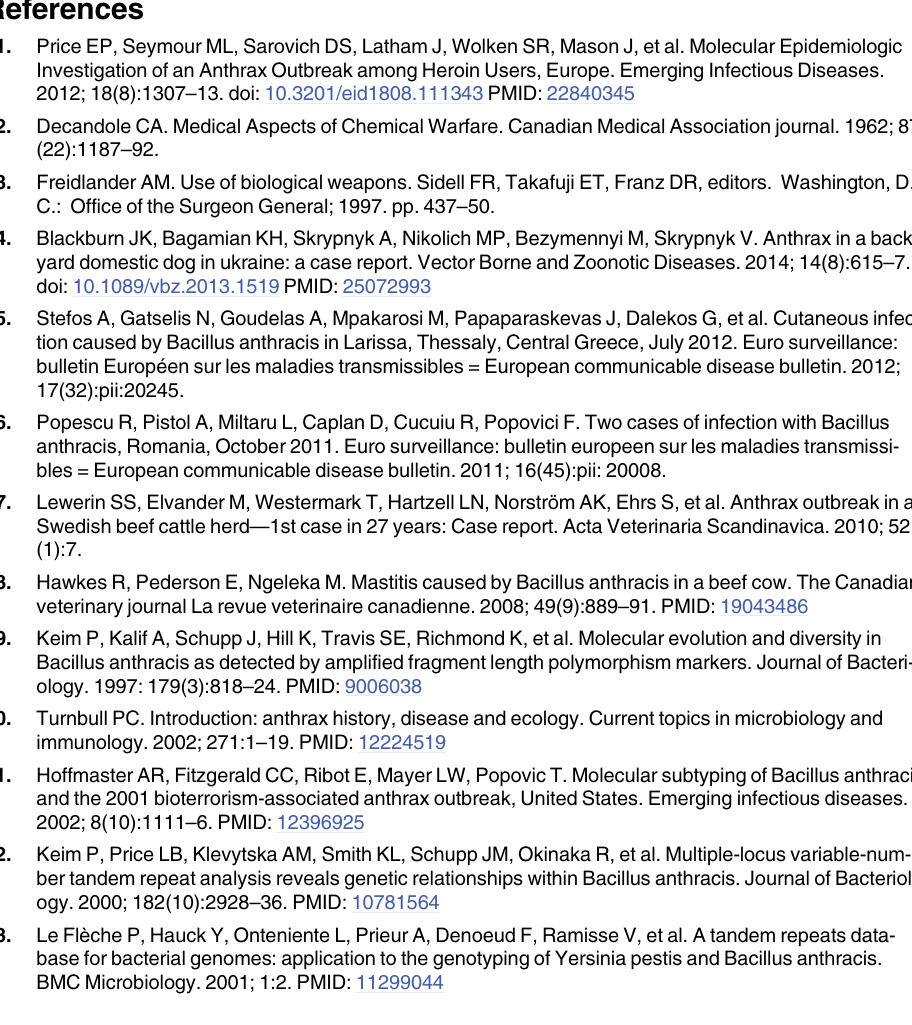
S2 Table. Genotyping of the isolated strains and vaccine strains (14).